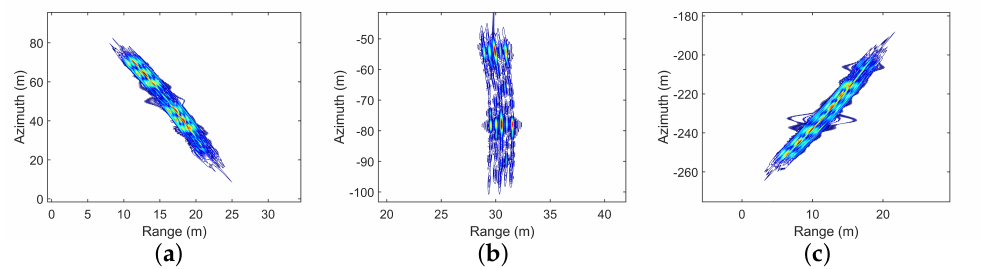
Figure 15. Imaging results of DT in different video frames. ( a ) Frame 17, ( b ) Frame 53, ( c ) Frame 81. The frame rate is 2.3687